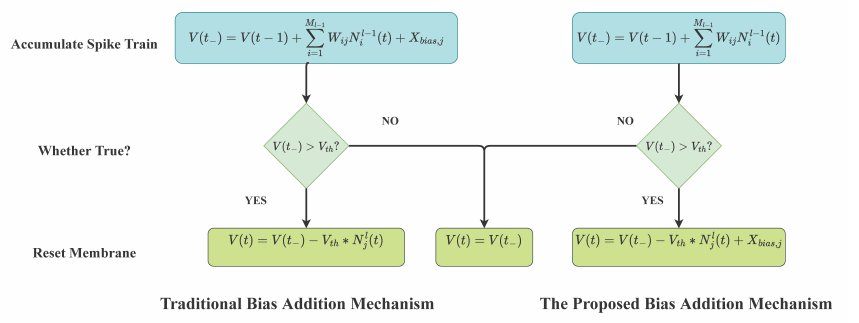
Figure 4. The computational process of IF neurons. The left side is the existing bias addition mechanism, which adds bias in the accumulate spike train phase and triggers a spike when the membrane potential exceeds the threshold; the new bias addition mechanism adds bias only when the membrane potential is reset to ensure that the membrane potential does not increase in the absence of